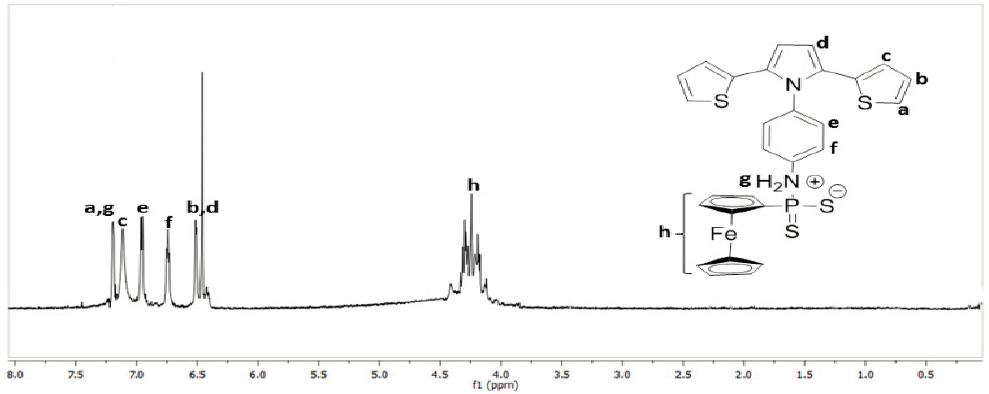
Figure 1. 1 H-NMR spectrum of (SNS-NH 2